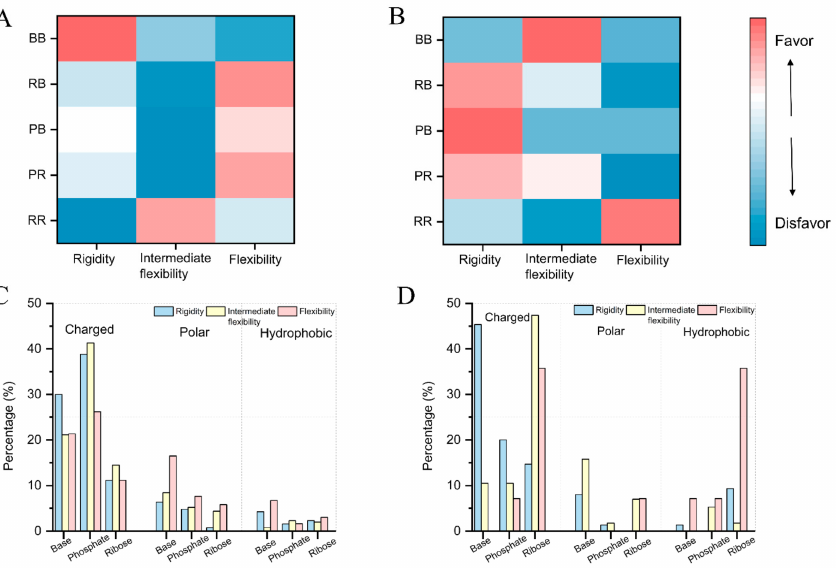
Figure 5. The distribution of hydrogen bonds ( A ) and vdW contacts ( B ) of nucleotides forming protein-binding pockets. The hydrogen bonds ( C ) and vdW contacts ( D ) distribution of proteins with pockets. There are five pairs of interactions: base–base (BB), ribose–base (RB), phosphate–base (PB), phosphate–ribose (PR), and ribose–ribose